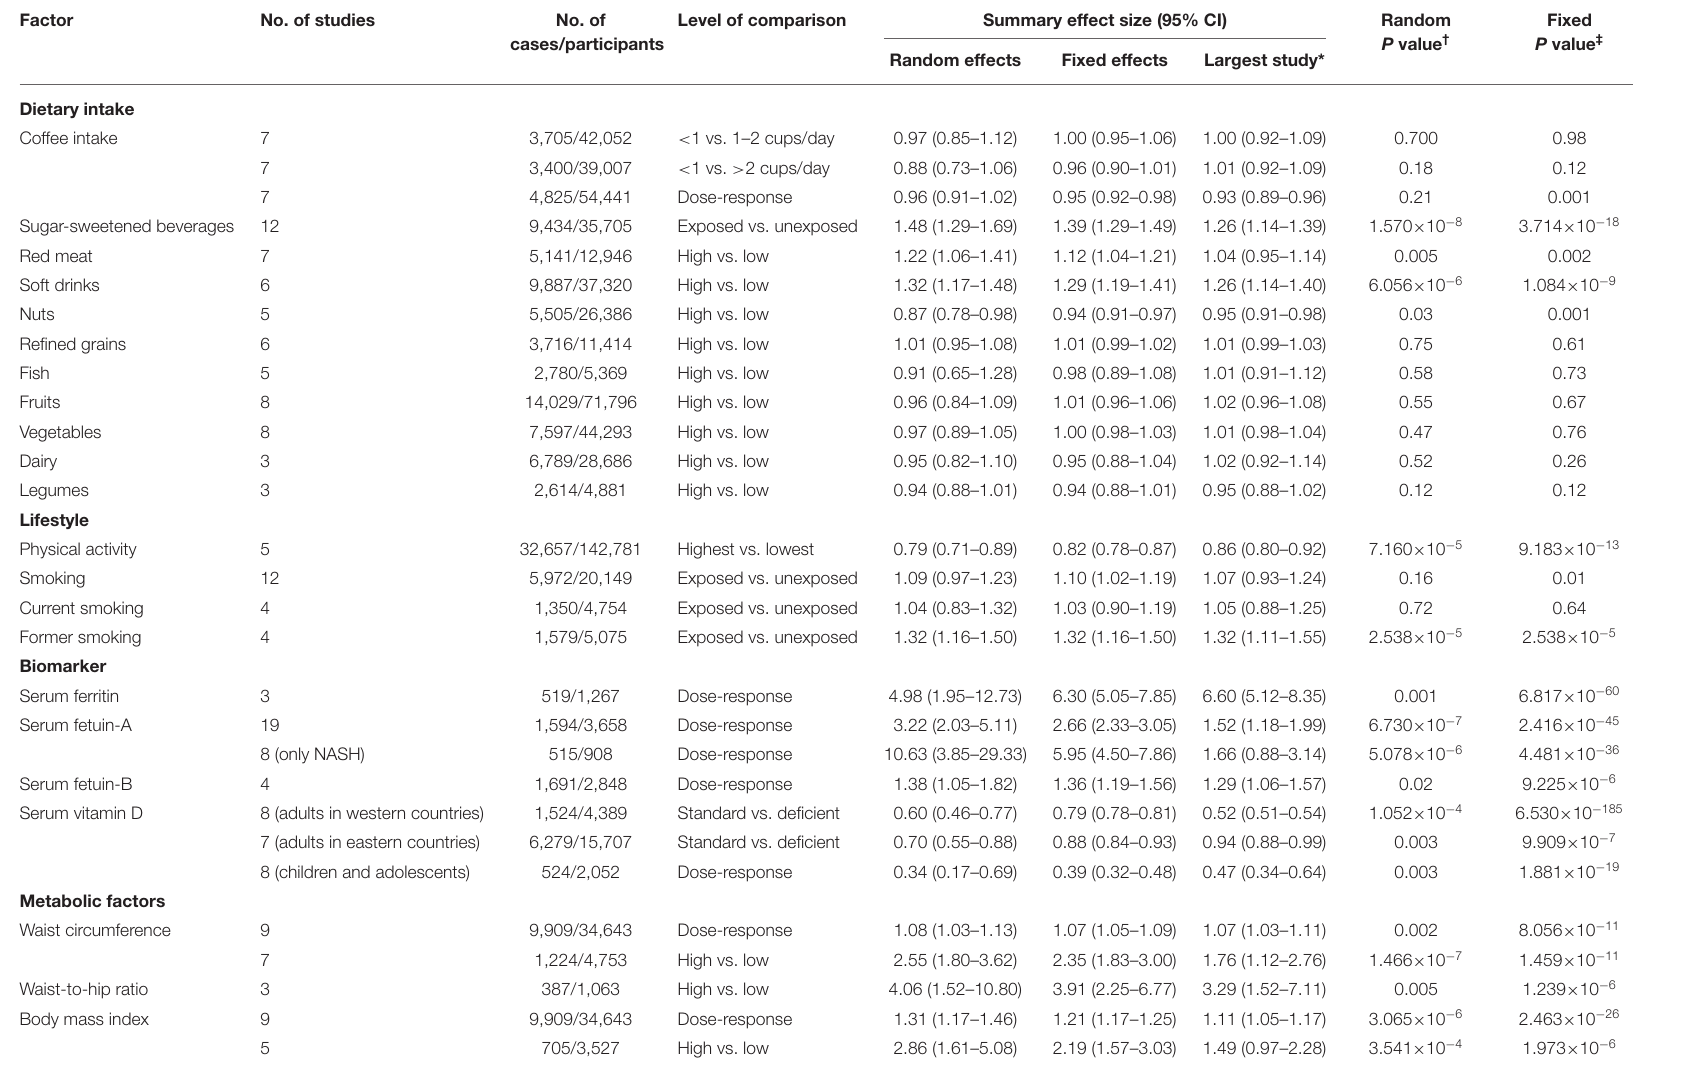
TABLE 1 | Characteristics and quantitative synthesis of the eligible meta-analyses of multiple risk factors for